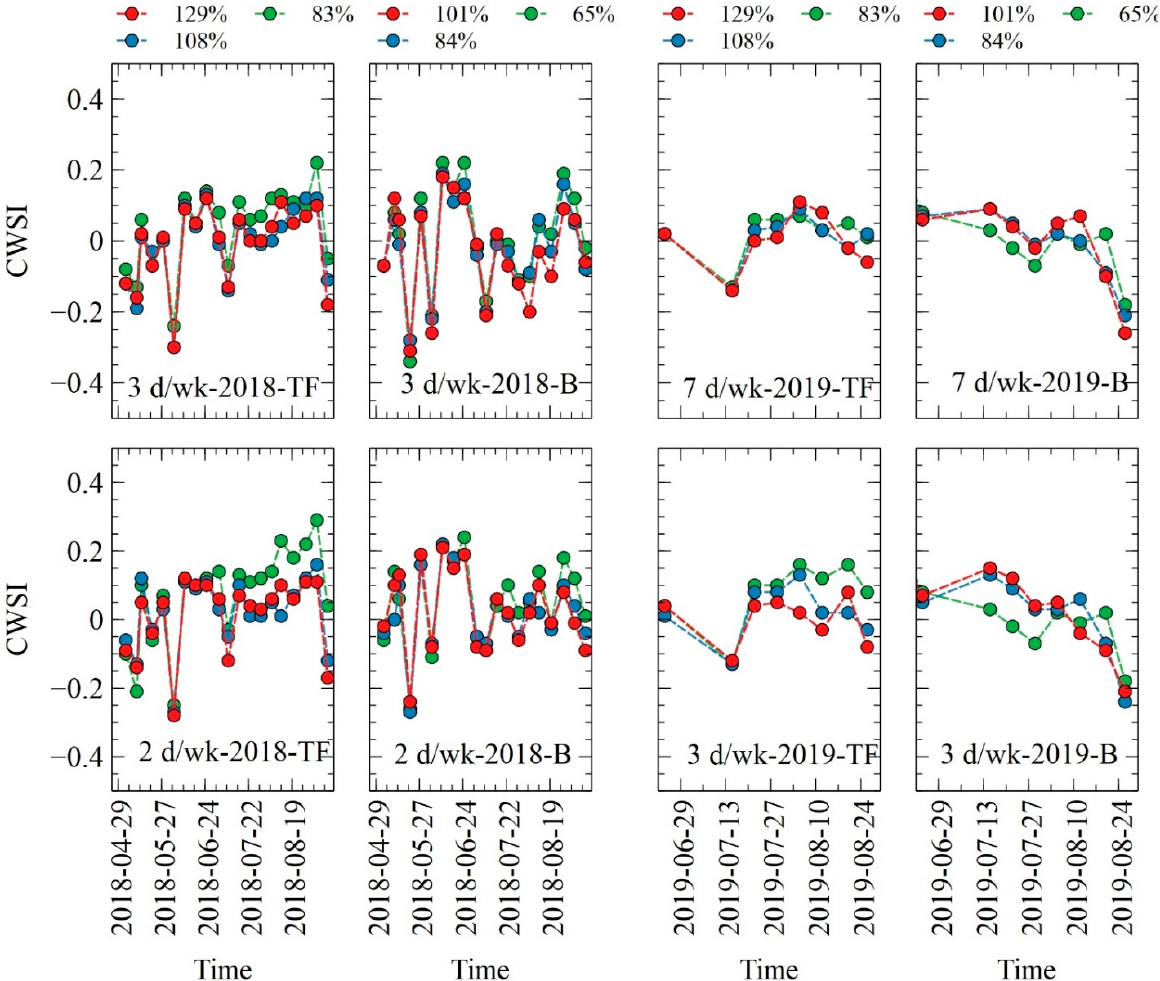
Figure 7. The crop water stress index (CWSI) dynamics for the hybrid bermudagrass (B) and tall fescue (TF) turfgrass plots under varying irrigation scenarios imposed in 2018 and 2019. d/wk: indicated irrigation frequency in days per week.